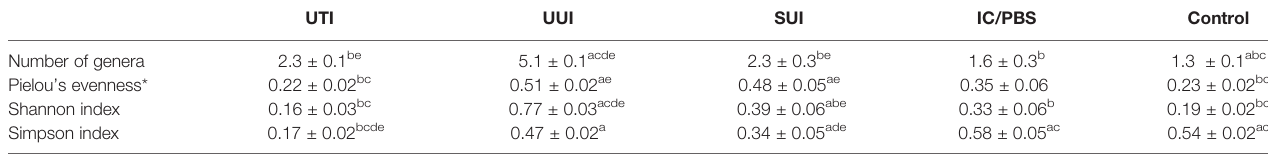
TABLE 2 | Age-adjusted diversity